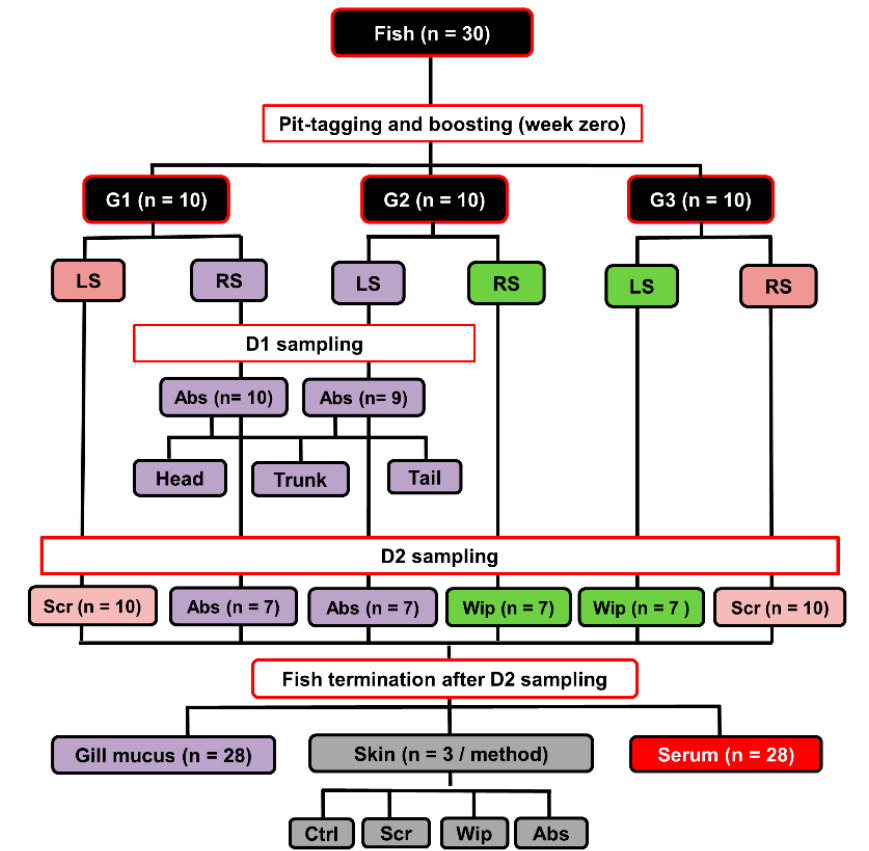
Figure 1. Schematic representation of the experiments conducted at the research aquaria facility, the figure shows how the total number of fish/samples were sub-divided and used in smaller experiments. Mucus samples collected by the same method have the same box color on the diagram. Fish were vaccinated at the beginning of the experiment and were sampled at two time-points (12- and 18-weeks post-vaccination). G: group, LS: left side, RS: right side, Ctrl: control, Scr: scraping, Abs: absorption, Wip: wiping, wpv: weeks post-vaccination. D1: First skin mucus sampling (12 wpv), D2: Second skin mucus sampling (18 wpv).